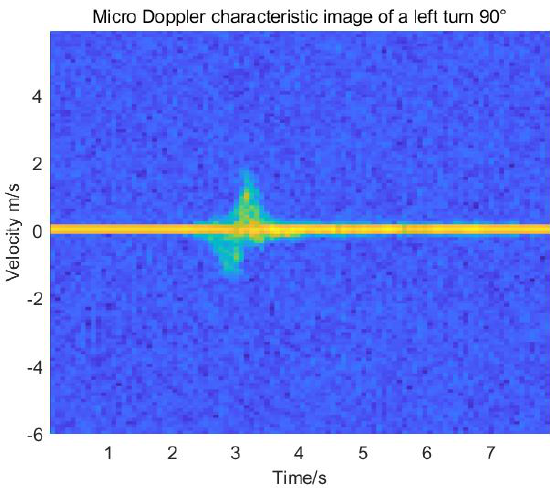
Figure 5. 90° micro-Doppler characteristic of the left rotating body. Figure 5. 90 ◦ micro-Doppler characteristic of the left rotating body.